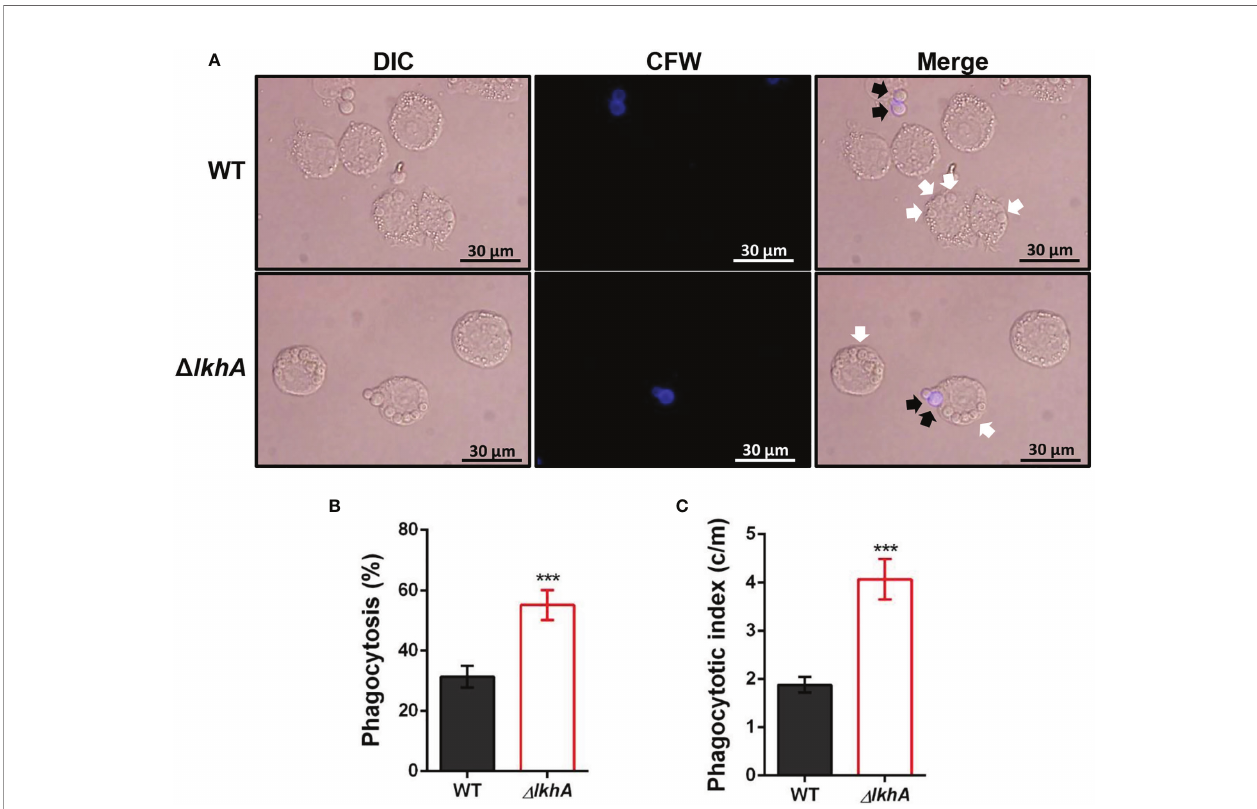
FIGURE 5 | Alveolar macrophage response to D A fl khA conidia. MH-S murine alveolar macrophages were challenged with a three-fold concentration of WT and D A fl khA conidia and then incubated for 4 hrs at 37°C in an atmosphere of 5% CO2. (A) Microscopic analysis of the uptake of the fungal conidia by MH-S macrophages. External conidia (black arrows) were stained by calco fl uor white (1 mg/mL in DPBS). White arrows indicate conidia endocytosed by macrophage cells. (B) Phagocytosis of conidia. The percentage of macrophages containing more than one ingested conidia was counted (n = 18). (C) Phagocytosis index. The average number of indigested conidia per macrophage (c/m) was calculated (n = 40). Statistical analysis was performed using the student ’ s t-test. ***P <